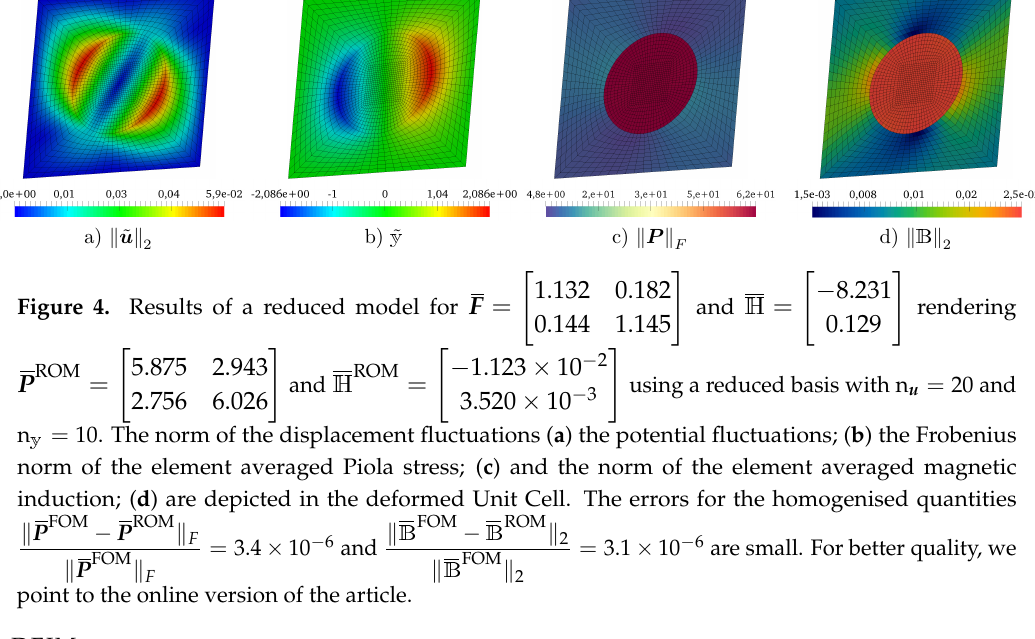
Figure 4. Results of a reduced model for F